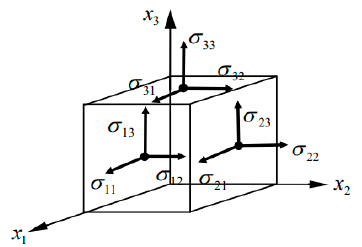
Figure 6. The nine stress components with respect to a Cartesian coordinate system.